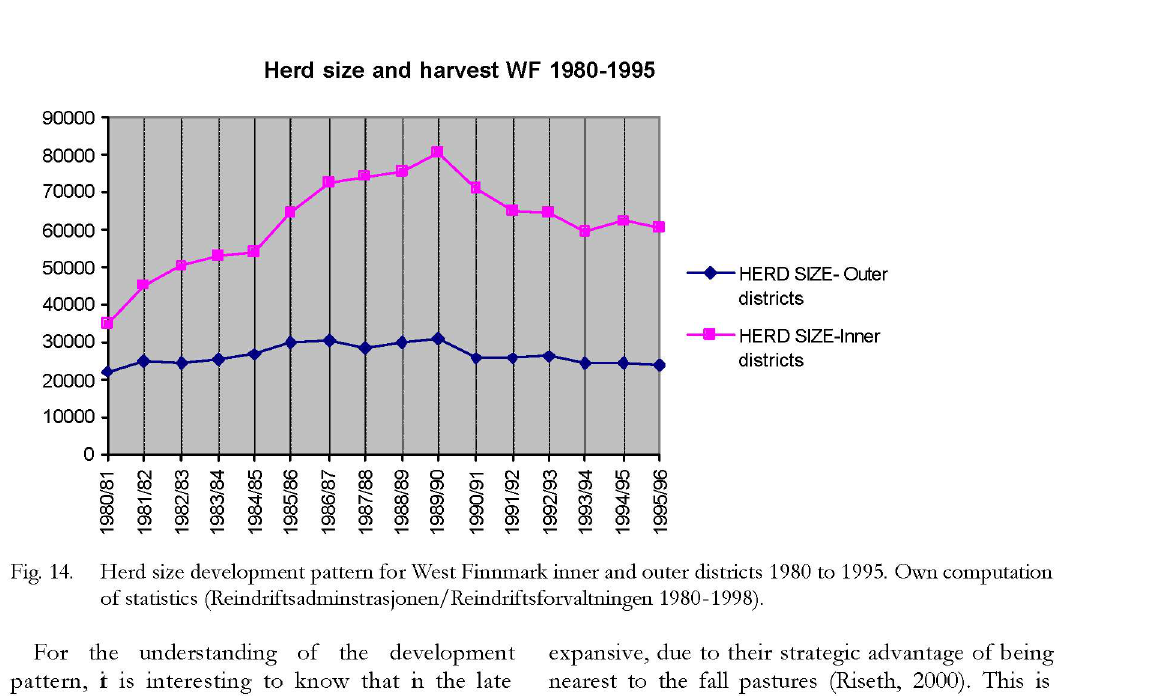
Herd size development pattern for West Finnmark inner and outer districts 1980 to 1995. Own computation of statistics (Reindriftsadminstrasjonen/Reindriftsforvaltningen 1980-1998).